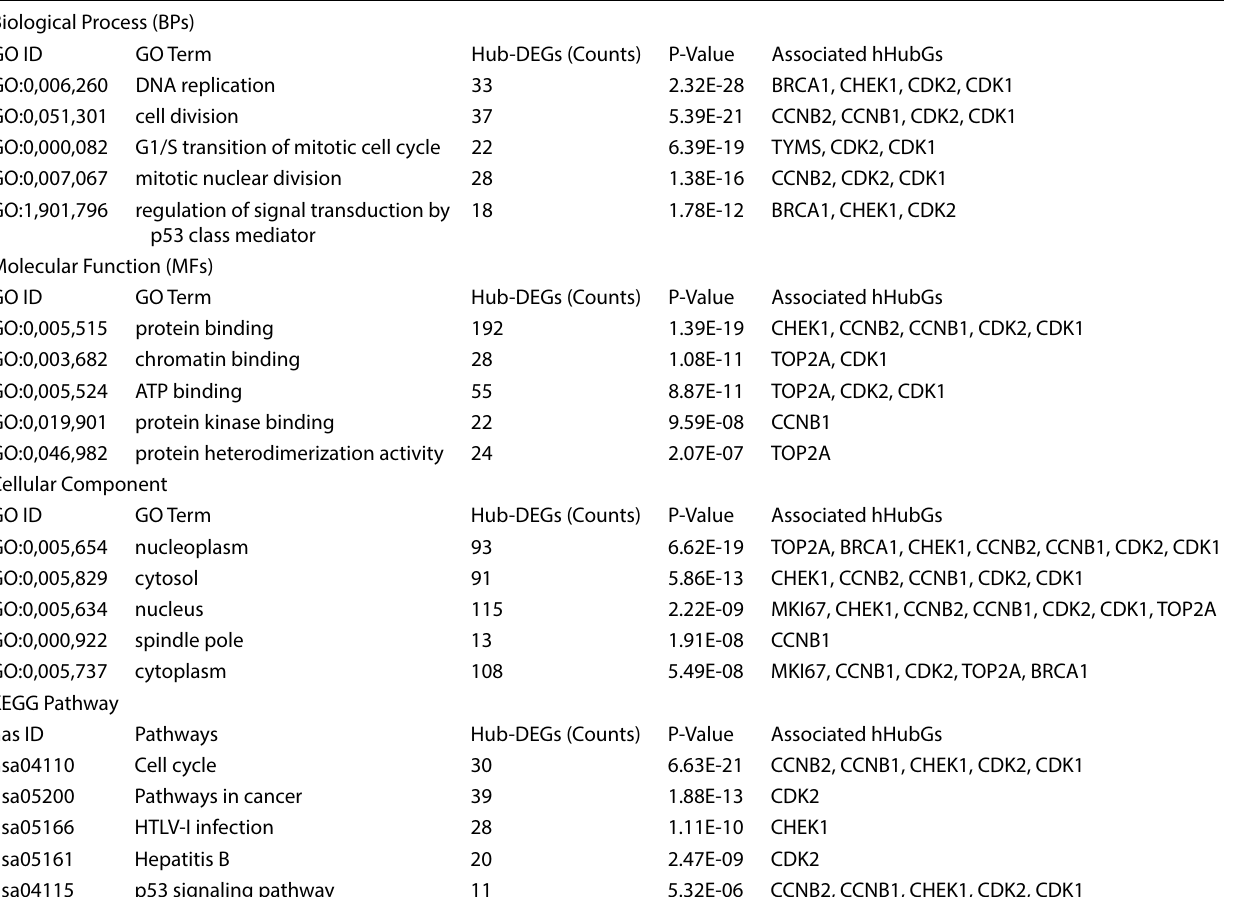
Table 1 The top five significantly (p-value < 0.001) enriched GO functions and KEGG pathways by hub/studied-genes involving hHubGs with CC diseases Biological Process